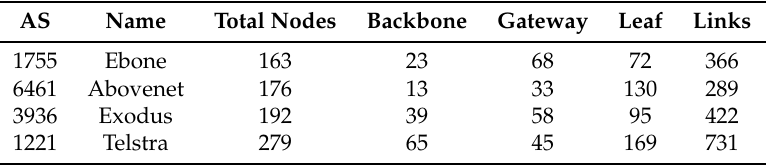
Table 1. Topology